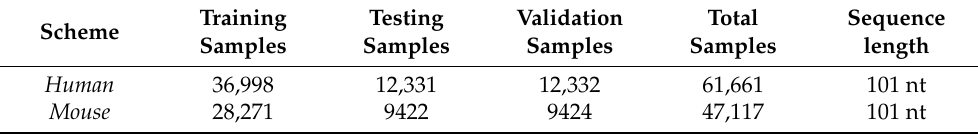
Table 3. Details pertaining to miCLIP-Seq